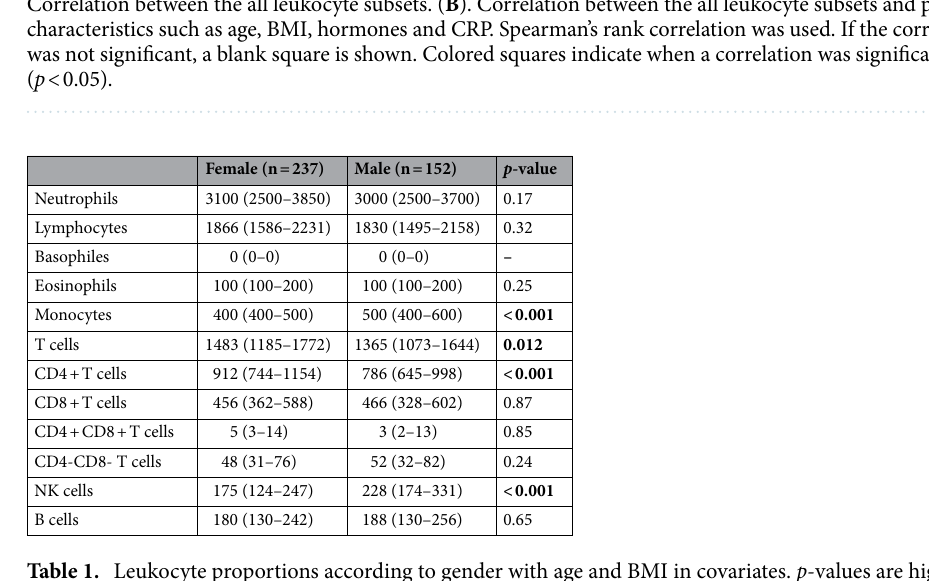
Table 1. Leukocyte proportions according to gender with age and BMI in covariates. p -values are highlighted in bold when